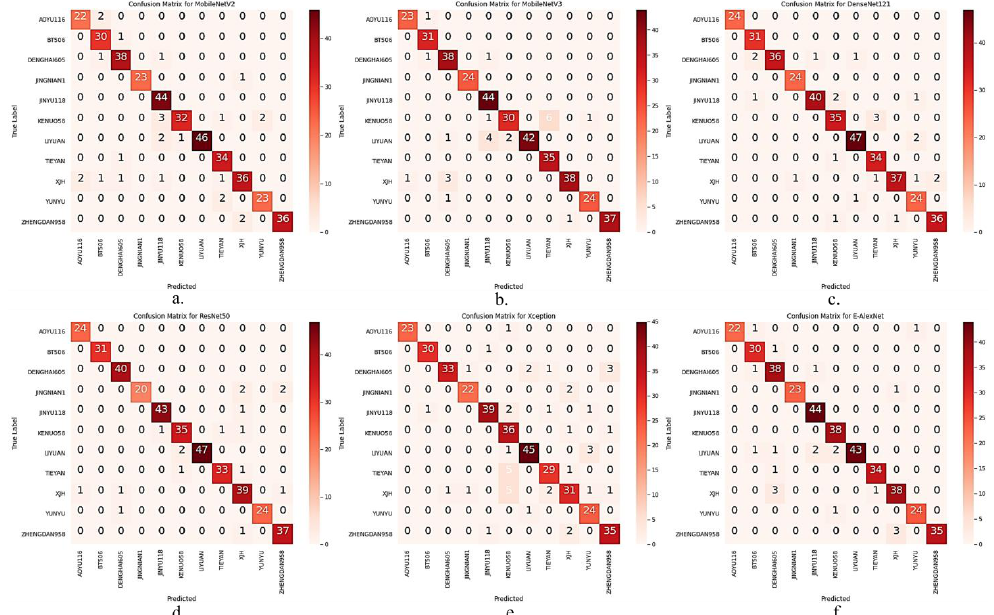
Figure 9. Comparison of confusion matrices for the other six models. ( a ) MobileNetV2; ( b ) Mo- bileNetV3; ( c ) DenseNet121; ( d ) ResNet50; ( e ) Xception; ( f ) E-AlexNet. As represented in Figure 9 the number of incorrect identifications of I_CBAM_MobileNetV2 in the test set was much lower than that of the other models in the comparison experiments. The overall number of correct identifications increased by 19 compared with MobileNetV2, after adding the I_CBAM module to the MobileNetV2 model. The test re- sults suggest that the I_CBAM module can effectively improve the maize seed variety identification ability of the MobileNetV2 model. Overall accuracy (OA), kappa coefficient, and model size were introduced to the I_CBAM_MobileNetV2 model as evaluation metrics, to evaluate all methods of the com- parison experiment quantitatively. The evaluation results are mentioned in Table 5.